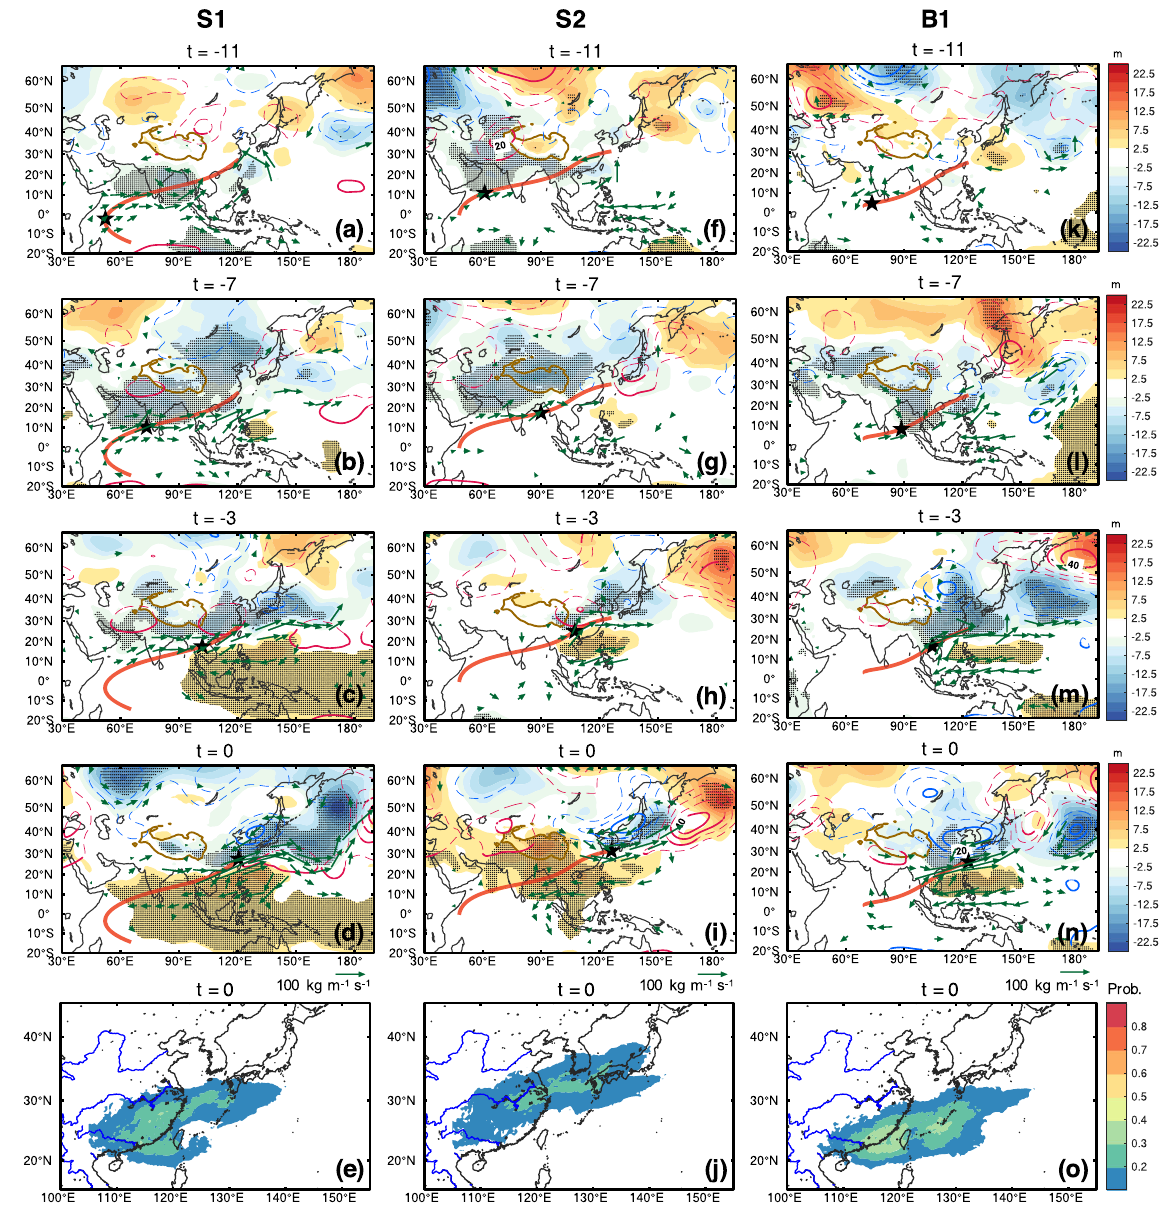
and vertically integrated vapor transport (IVT) anomalies (vector, unit: kg m − 1 s − 1 ) on day − 11, − 7, − 3 and 0 with respect to the occurrence of rain belt events (95 events), with day 0 being the fi rst day of the event. e A risk map of the S1 ’ s rain belt occurrence probabilities on day 0. f – j Composites and the risk map for the S2 channel (93 events). k – o for the B1 channel (78 events). The solid red line represents the regressed moisture channel, along which the black star denotes the regressed position of the moist air column corresponding to the lead time. Contours in red (blue) denote positive (negative) values. Black dots over the shading, thick solid contours and the vectors all indicate statistically signi fi cant values at the 0.05 level (Student ’ s t